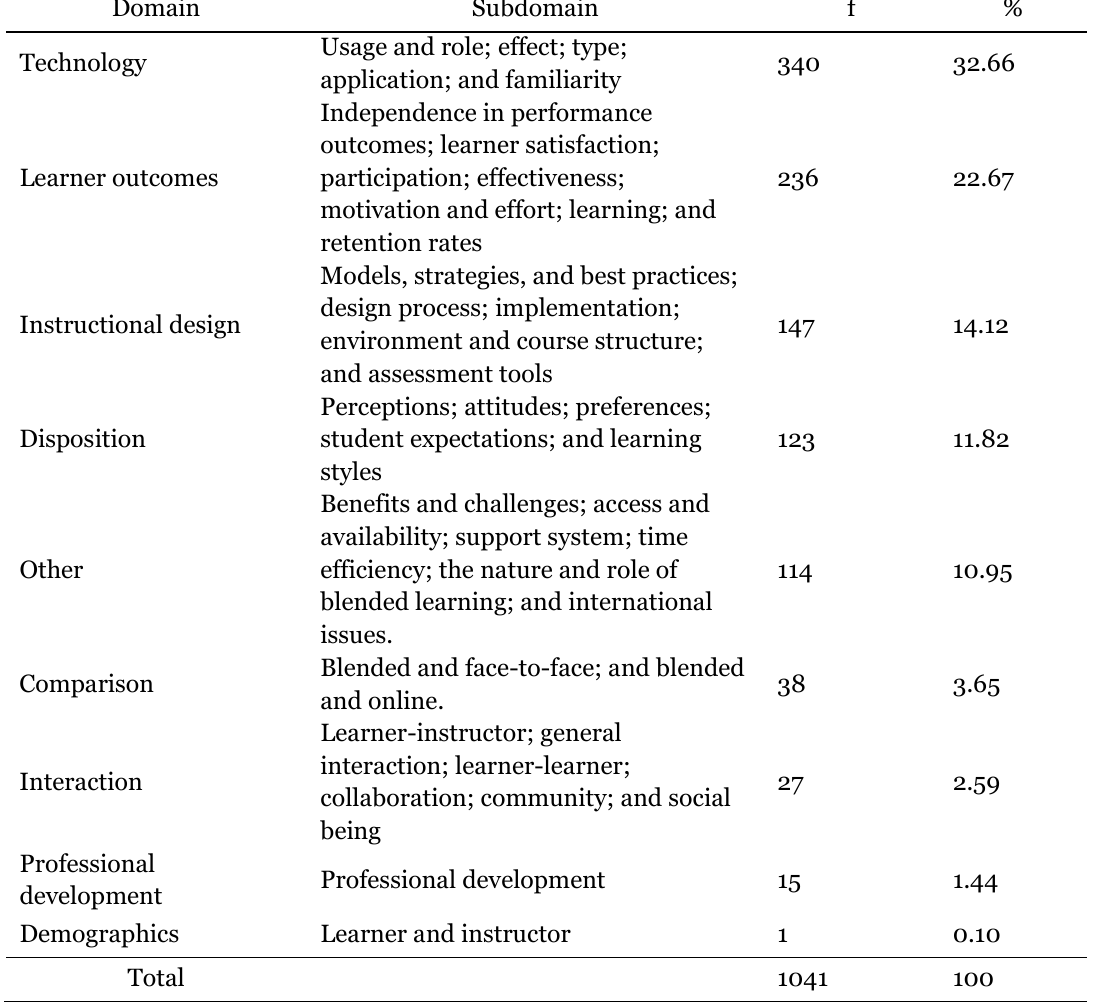
Distribution of Studies by Subject Area